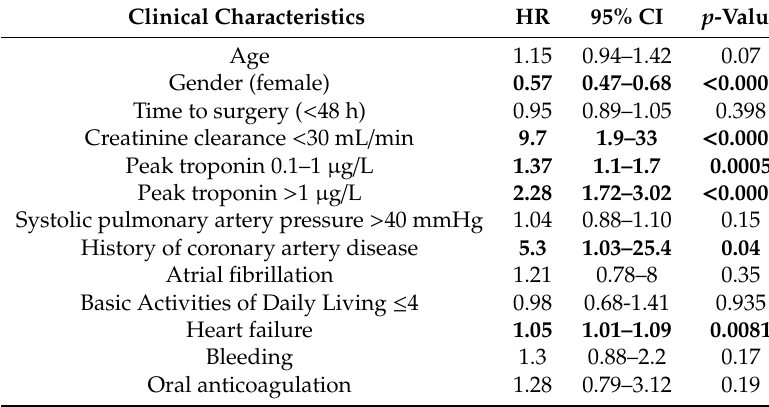
Table 5. Factors related to early mortality at multivariate